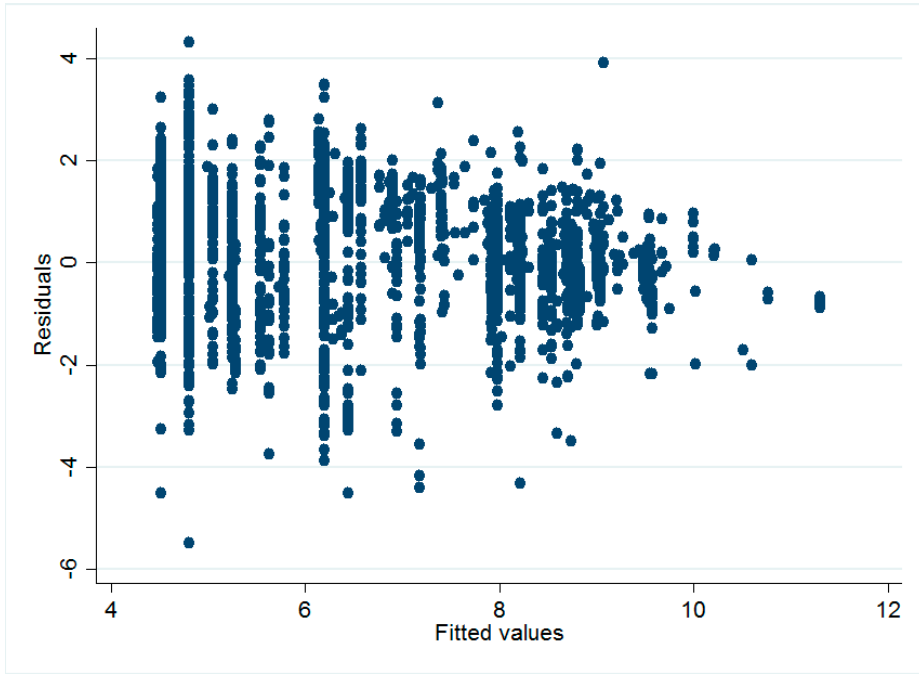
Figure 2. Relationships between residuals and fitted values (heteroscedasticity). Healthcare 2020 , 8 , x